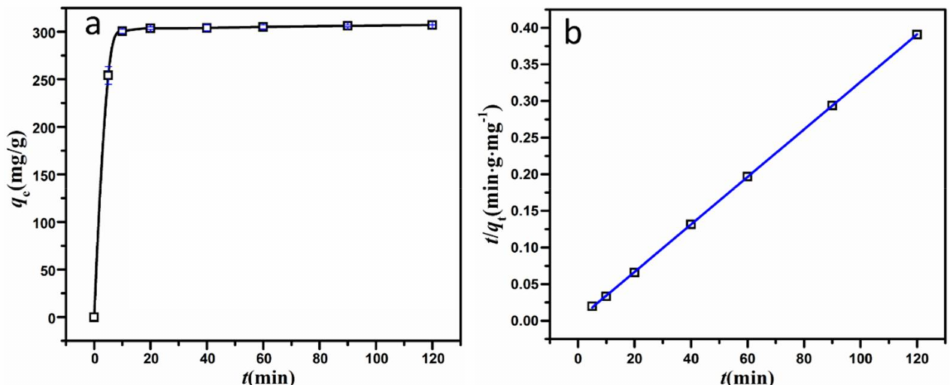
Figure 6. ( a ) Variation of adsorption quantity of MSH-1.75 as a function of contact time; and ( b ) the liner fitting of pseudo-second-order kinetics.